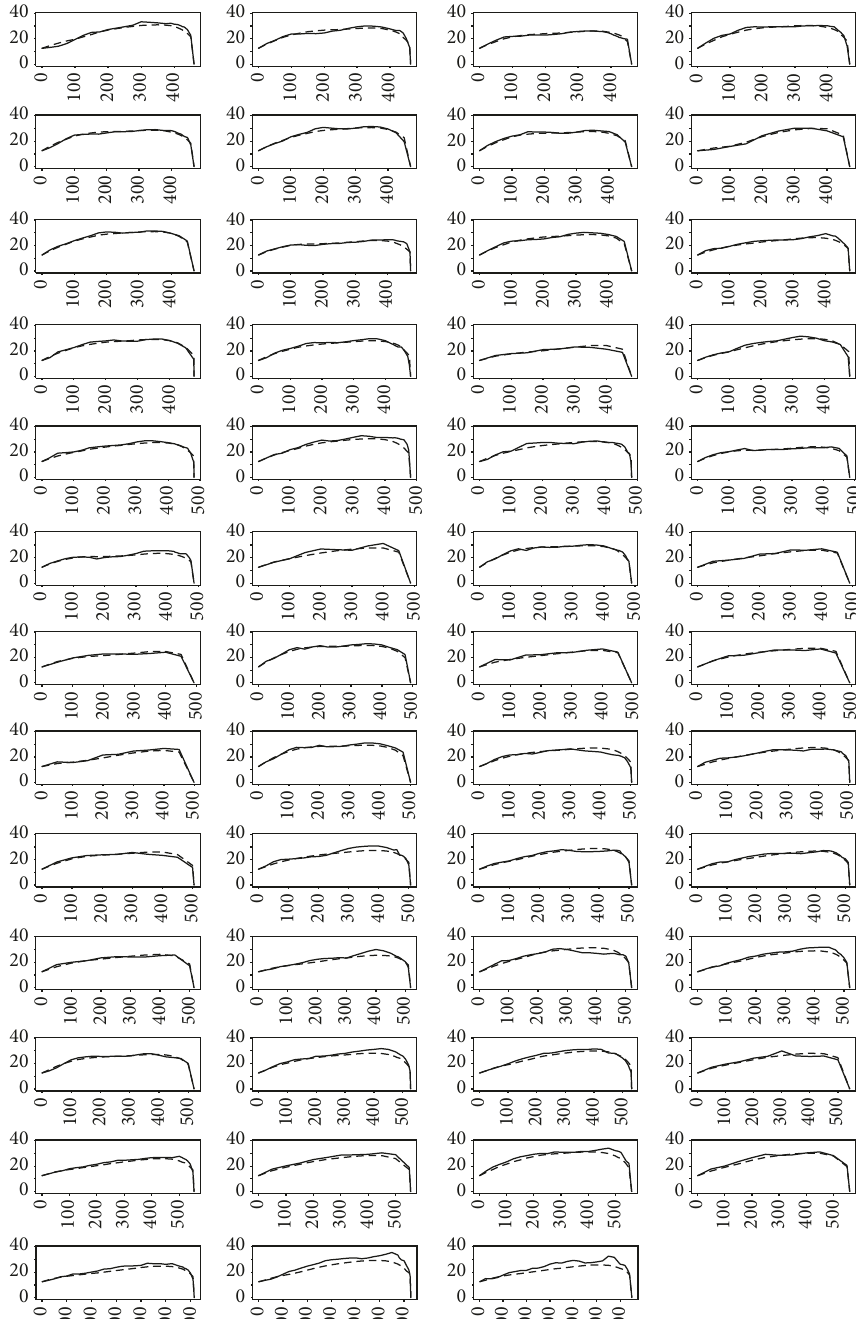
Figure 9: Observations (solid) and predictions (broken) for the shape of the samples (numbers 61–111, length of 460 to 650 mm), using proposed Bayesian method with M-RM prediction model. The samples are ordered by the length. The horizontal and vertical axes indicate the distance (mm) from the cutoff point and the radius (mm), respectively.